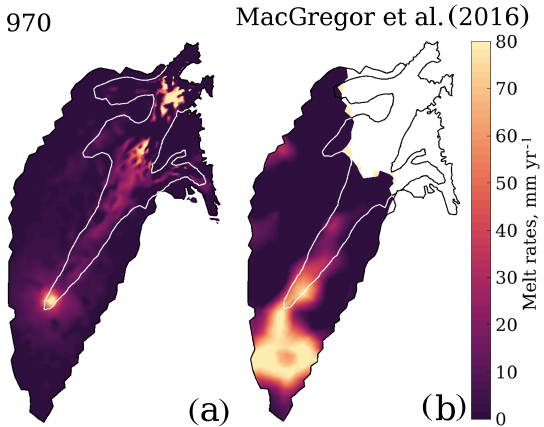
Figure 6. Comparison of the basal melt rates computed for the plume970 experiment (a) and the gridded basal melt rate estimates of Macgregor et al. (2016) interpolated onto our model mesh (b) . White lines show the observed 50myr − 1 velocity